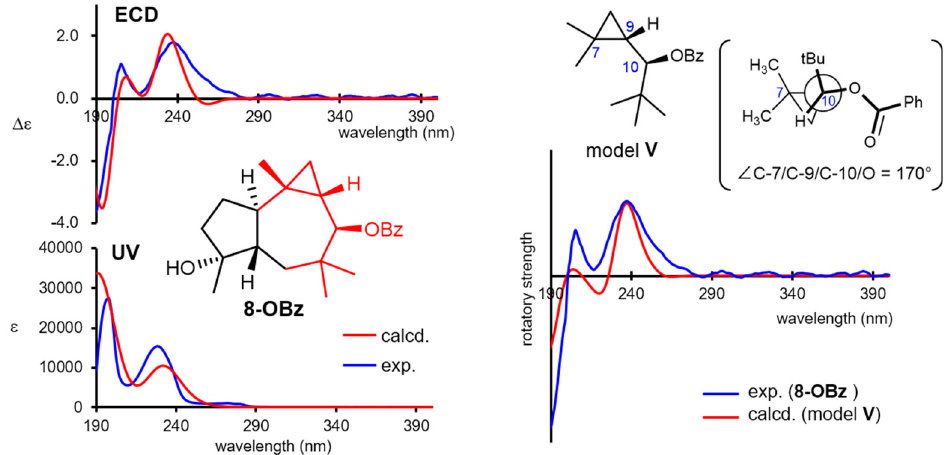
Figure 6. Experimental and calculated ultraviolet/electronic circular dichroism (ECD) spectra of 8-OBz and calculated ECD spectrum of model V by setting the dihedral angle ∠ C-7/C-9/C-10/O to 170°.